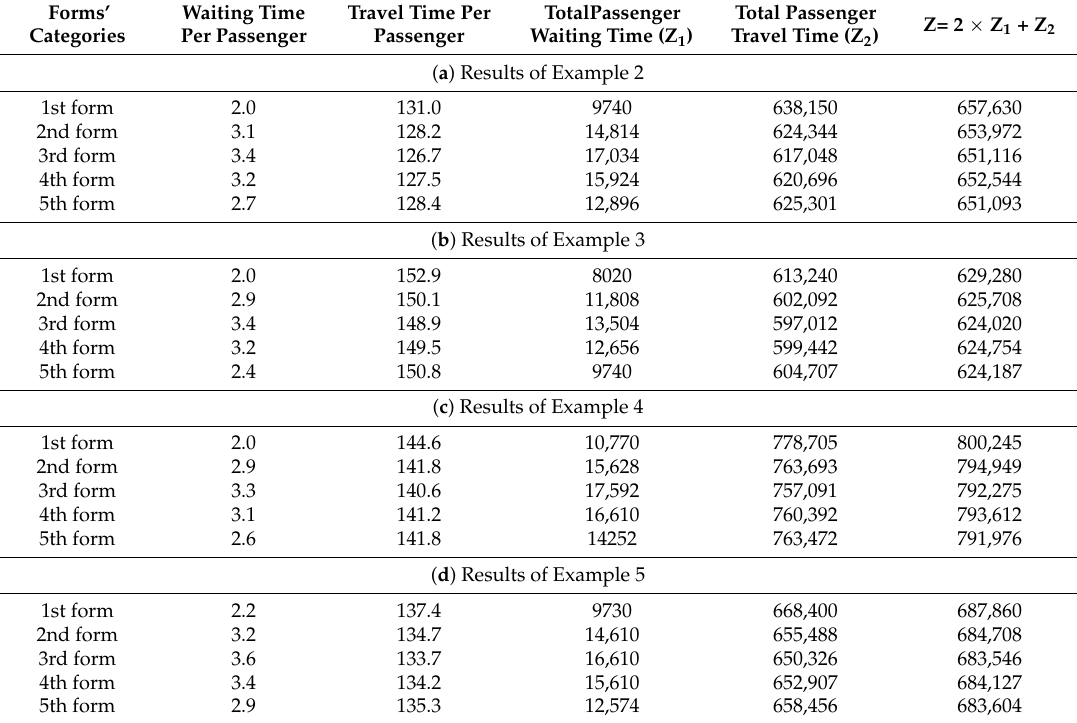
Table 7. Results of performance analysis of different demands (unit: